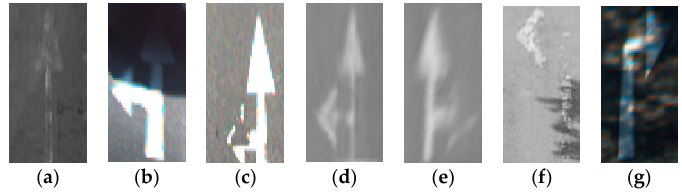
Figure 13. Examples of correct recognition cases: ( a ) forward arrow (FA); ( b – d ) forward-left arrow (FLA); ( e ) forward-right arrow (FRA); ( f ) left arrow (LA); ( g ) right arrow (RA).